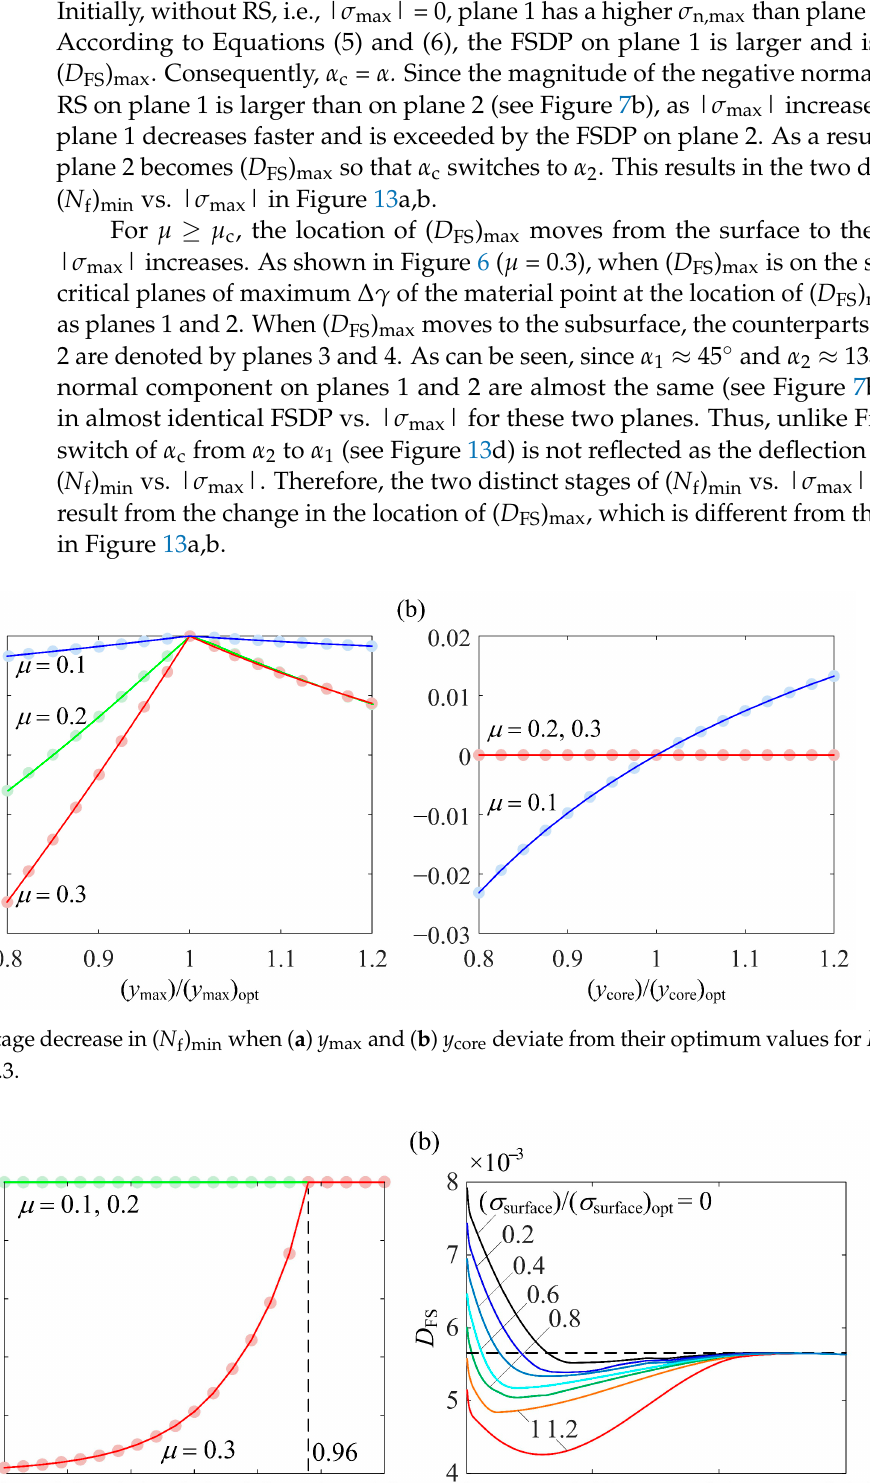
Figure 12. ( a ) The percentage decrease in ( N f ) min for P / P rated = 1 and μ = 0.1, 0.2, and 0.3 and ( b ) the variation of the D FS distribution along the depth for P / P rated = 1 and μ = 0.3 when σ surface deviates from ( σ surface ) opt .